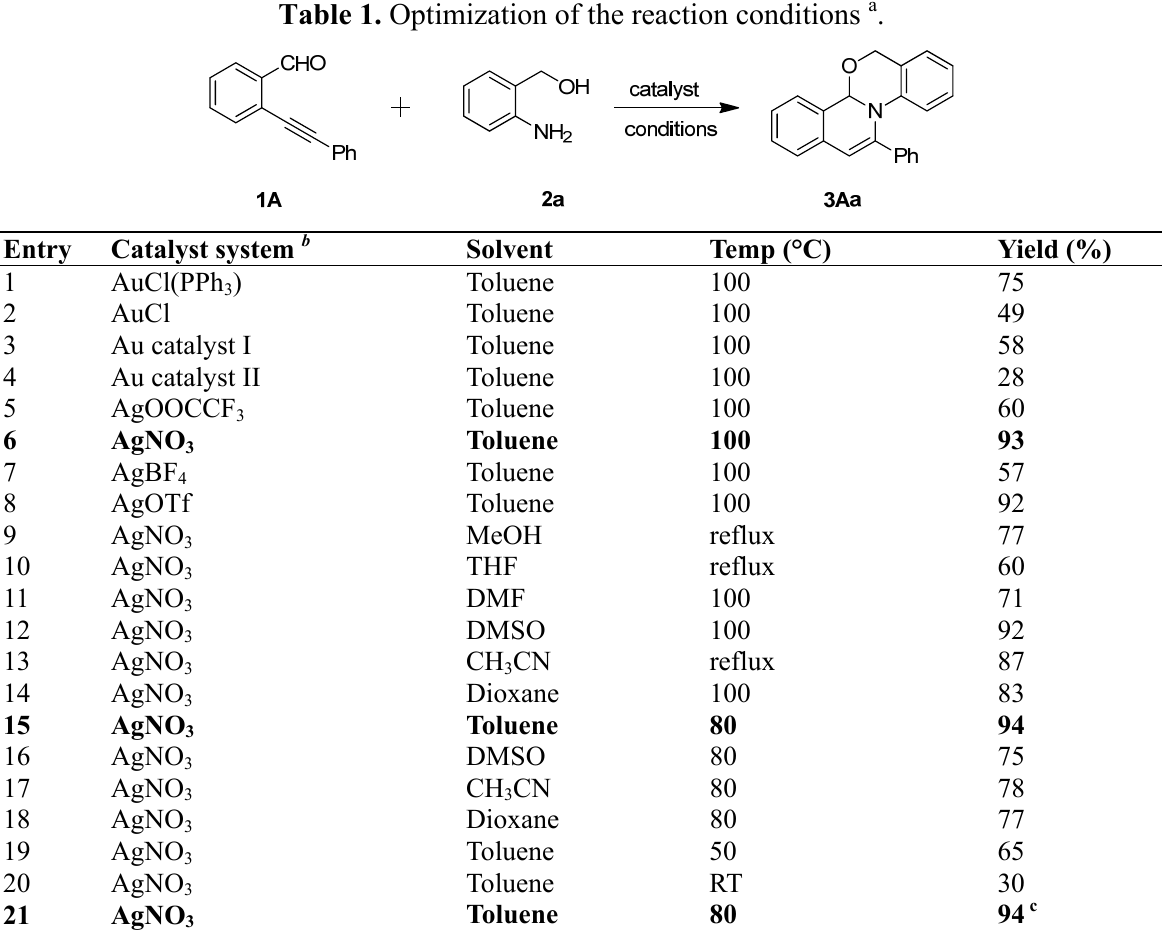
Table 1. Optimization of the reaction conditions a